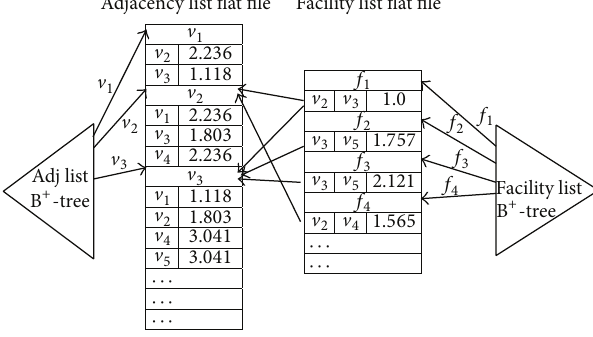
Figure 6: Disk-based storage